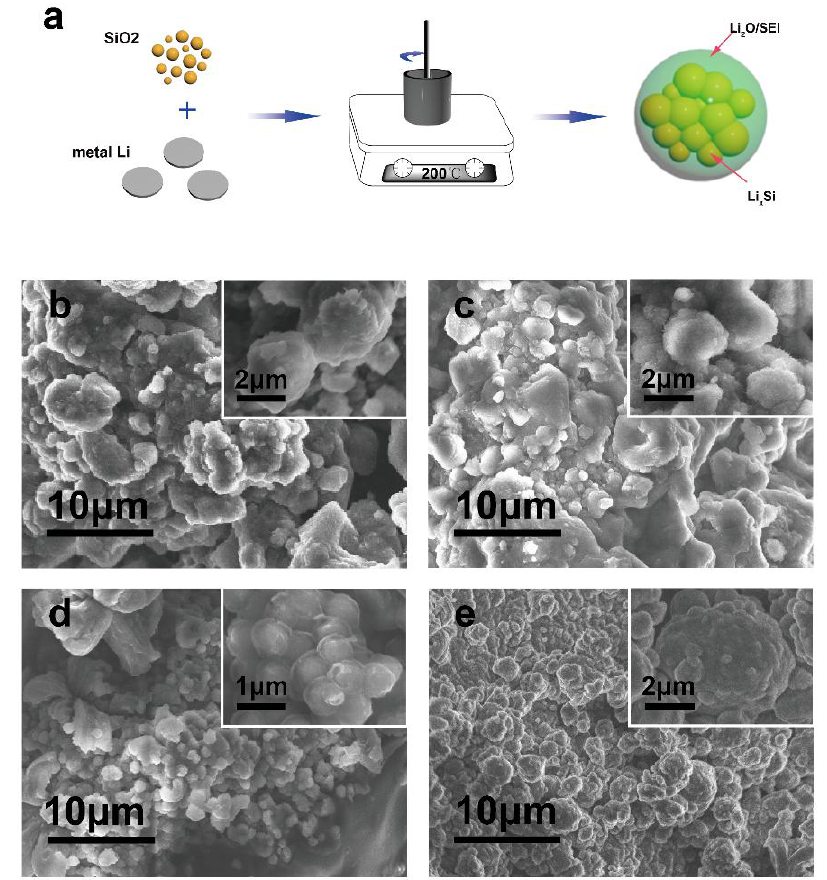
Figure 2. ( a ) Schematic of the thermal-alloying process of the SiO 2 with lithium metal; ( b – e ) SEM images of Li x Si/Li 2 O-1, Li x Si/Li 2 O-2, Li x Si/Li 2 O-3, and Li x Si/Li 2 O-4, respectively.